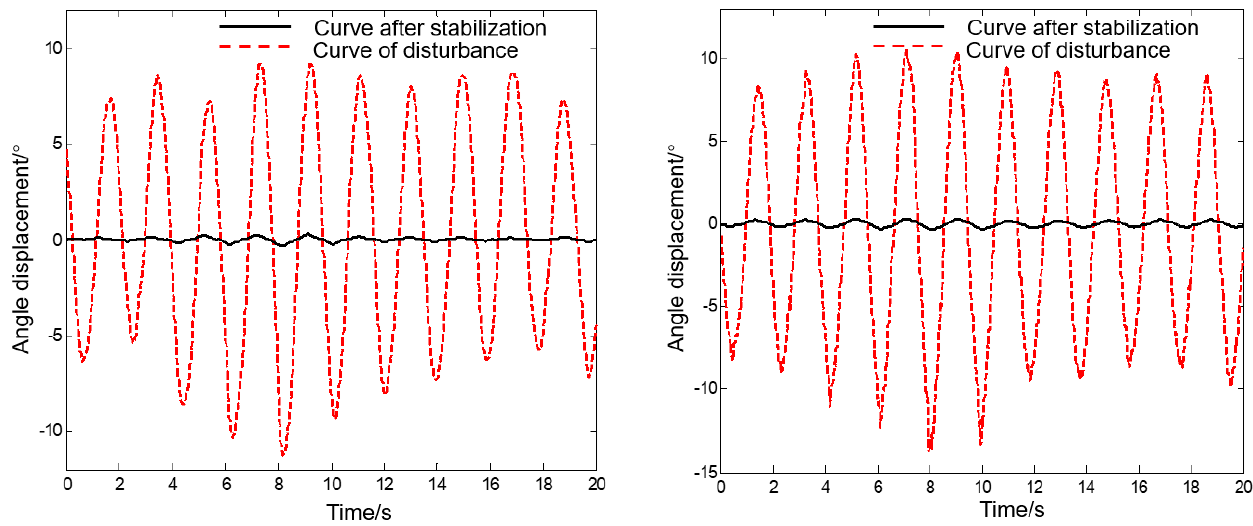
Figure 23. System stability curve at ±10° periodic wave disturbance.